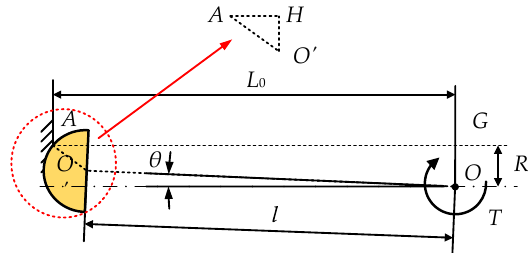
Figure 6. Ultimate position of the roller.